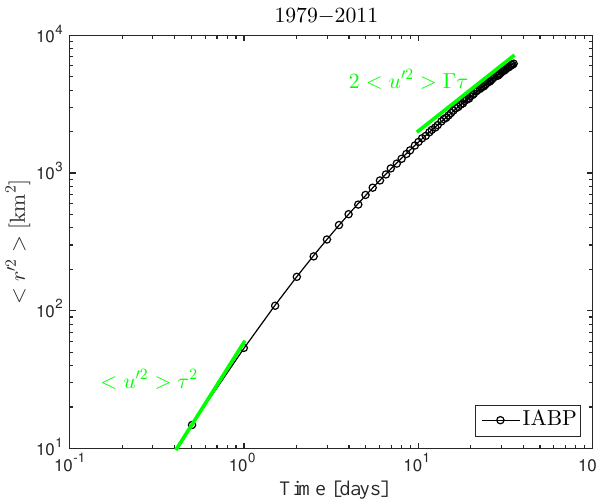
Figure 4. Ensemble mean of the variance of the fluctuating dis- placements < r (cid:48) 2 > for the winter seasons 1979–2011 for IABP. The green lines correspond to Eqs. (14) and (15) and are shown for